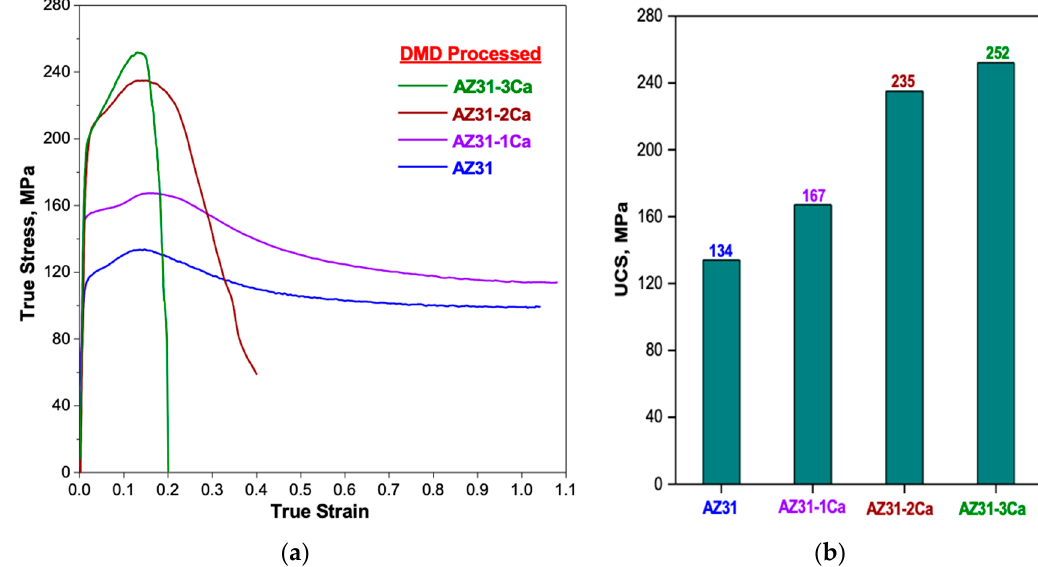
Figure 3. ( a,b ) Stress-strain curves obtained in compression for AZ31, AZ31-1Ca, AZ31-2Ca, and AZ31-3Ca alloys. The ultimate compression strengths of the alloys are also shown for comparison.